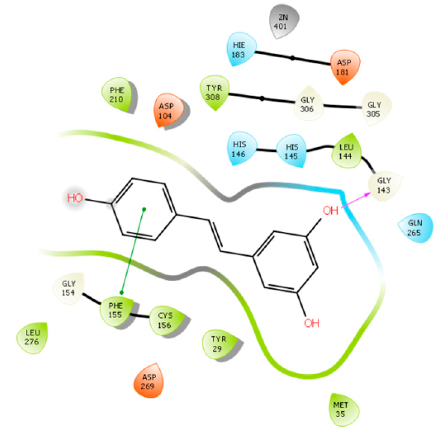
Figure 5. RVT interactions with HDAC-2 binding site.